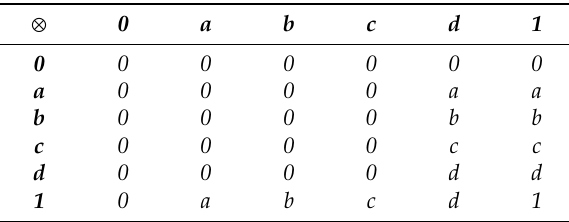
Table 8. The operation ⊗ on X